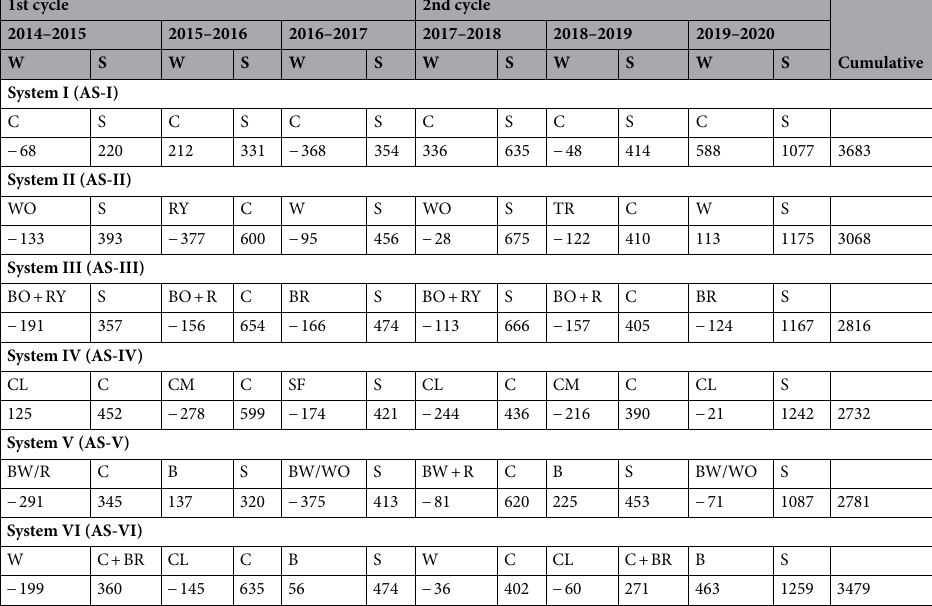
Table 4. Profit (USD ha −1 ) of the grain production systems for the 2014–2015 to 2019–2020 crop years, considering quarterly price peaks in Londrina, state of Paraná, Brazil. . W winter, S summer, WO white oat, BO black oat, BR brachiaria, CL canola, CM crambe, RY rye, SF safflower, B bean, C corn, R forage radish, S soybean, W wheat, BW buckwheat, TR